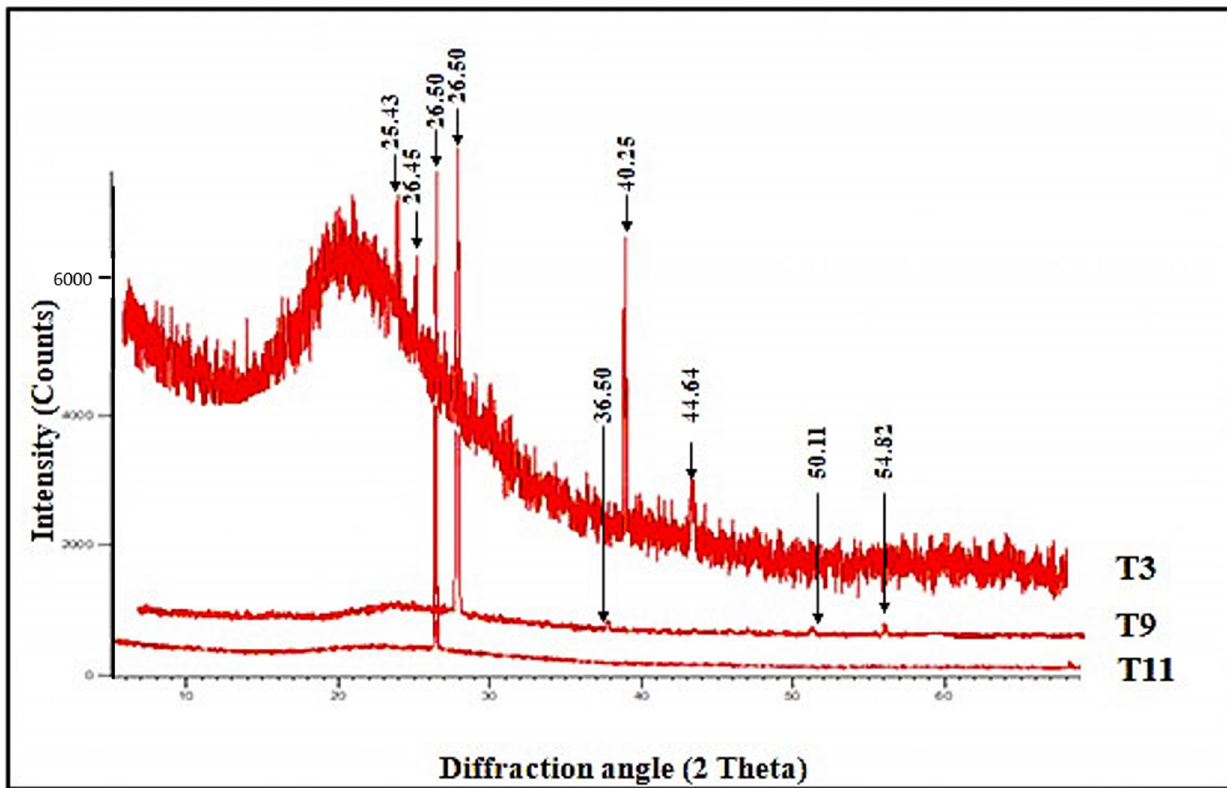
Figure 1. X-ray diffractogram of mixture at different stages of composting (T3: 3rd month, T9: 9th month and T11: 11th month).